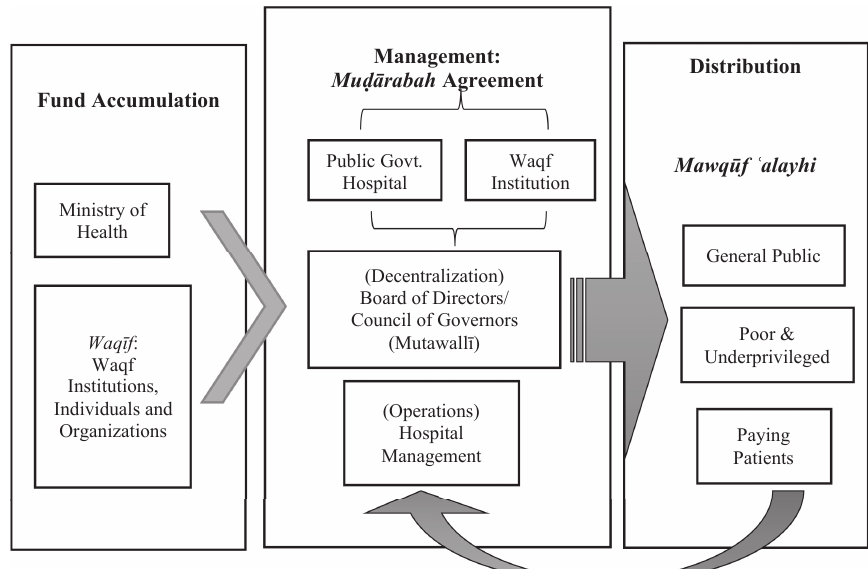
Figure 4. A framework for the corporate waqf-based